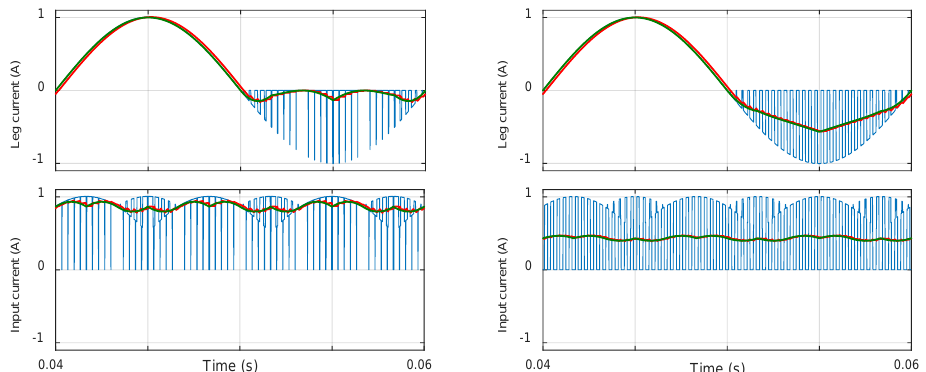
Figure 3. One leg input current (top) and total inverter input current (bottom): instantaneous value (blue trace), its numerically averaged value over the switching period (red), and theoretical value (green) in case of for m = 0.577/2 and m = 0.577 (from right to left), I ac = 1 A and ϕ = 0°.